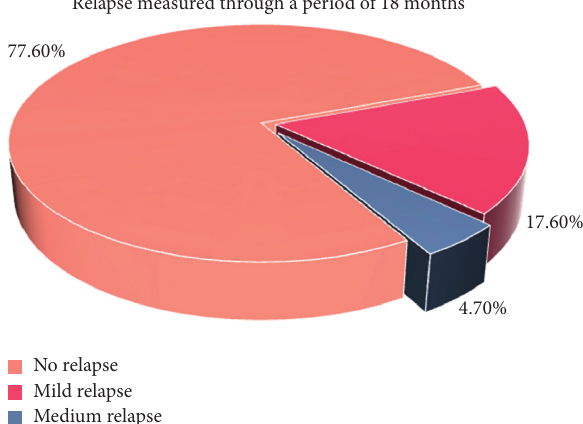
Figure 9: The relapse scores measured 18 months after the final